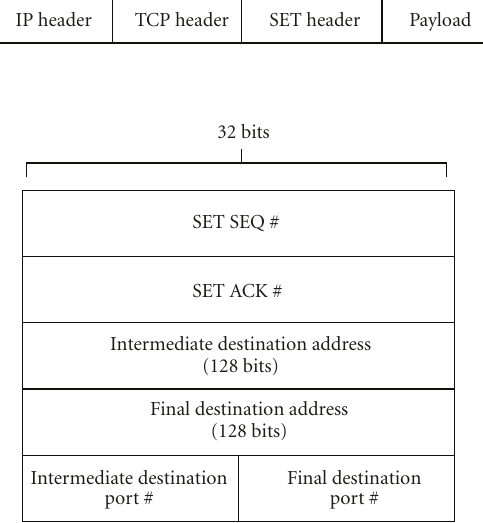
Figure 4: SET architecture.